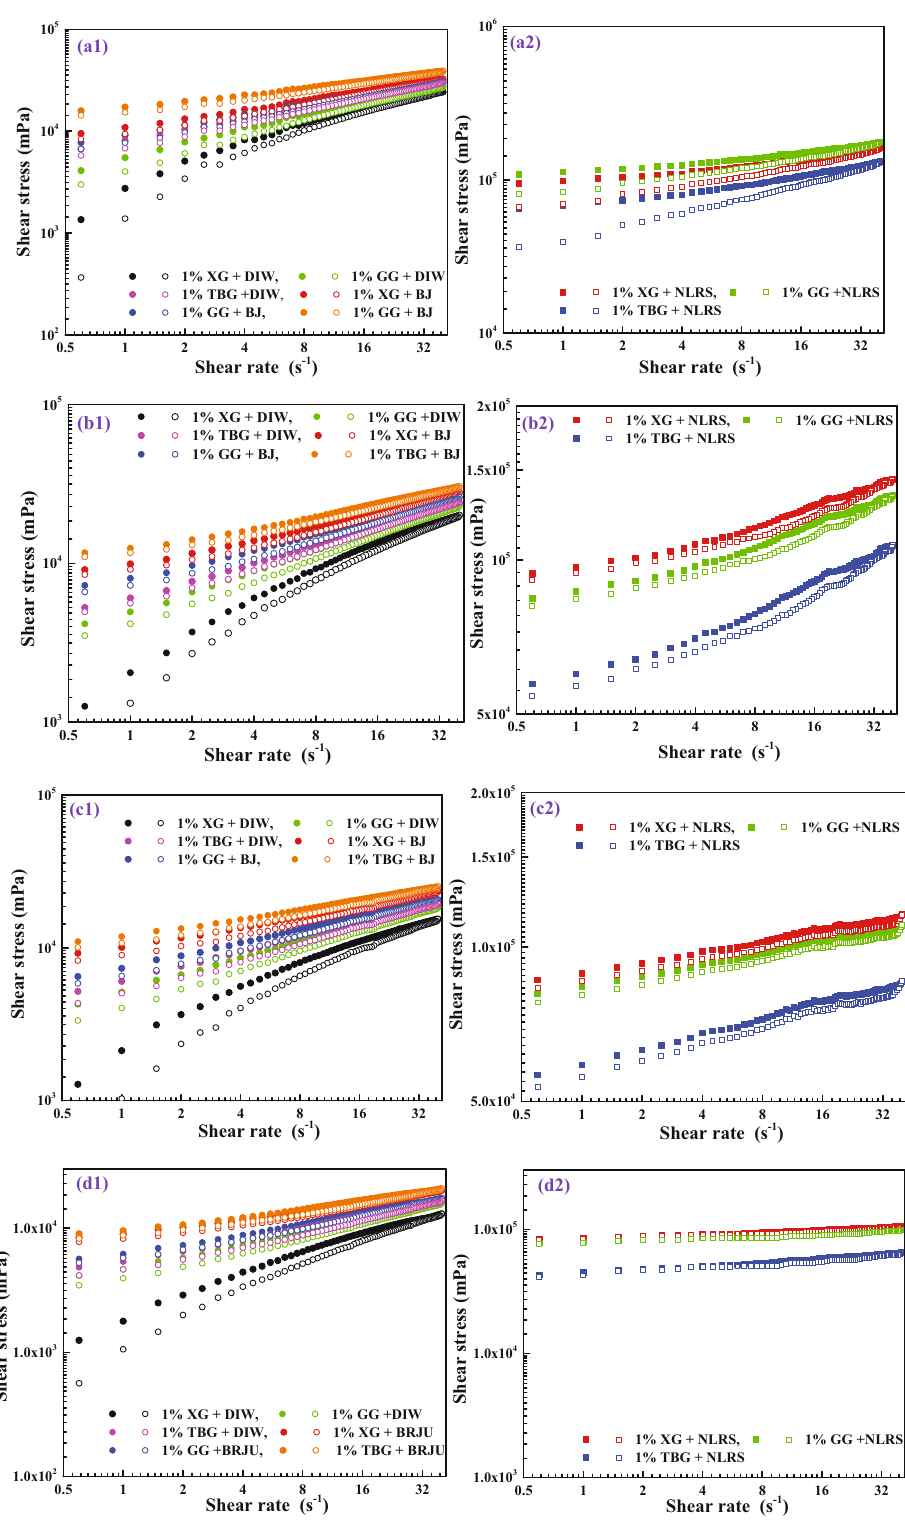
Figure 6: Under the in fl uence of di ff erent external factors, the fl ow curve changes with the increase and decrease of the shear rate: ( a1 ) and ( a2 ) : 40°C, ( b1 ) and ( b2 ) : 50°C, ( c1 ) and ( c2 ) : 60°C, ( d1 ) and ( d2 ) : 70°C. Solid: the shear rate is from small to large, hollow: the shear rate is from large to